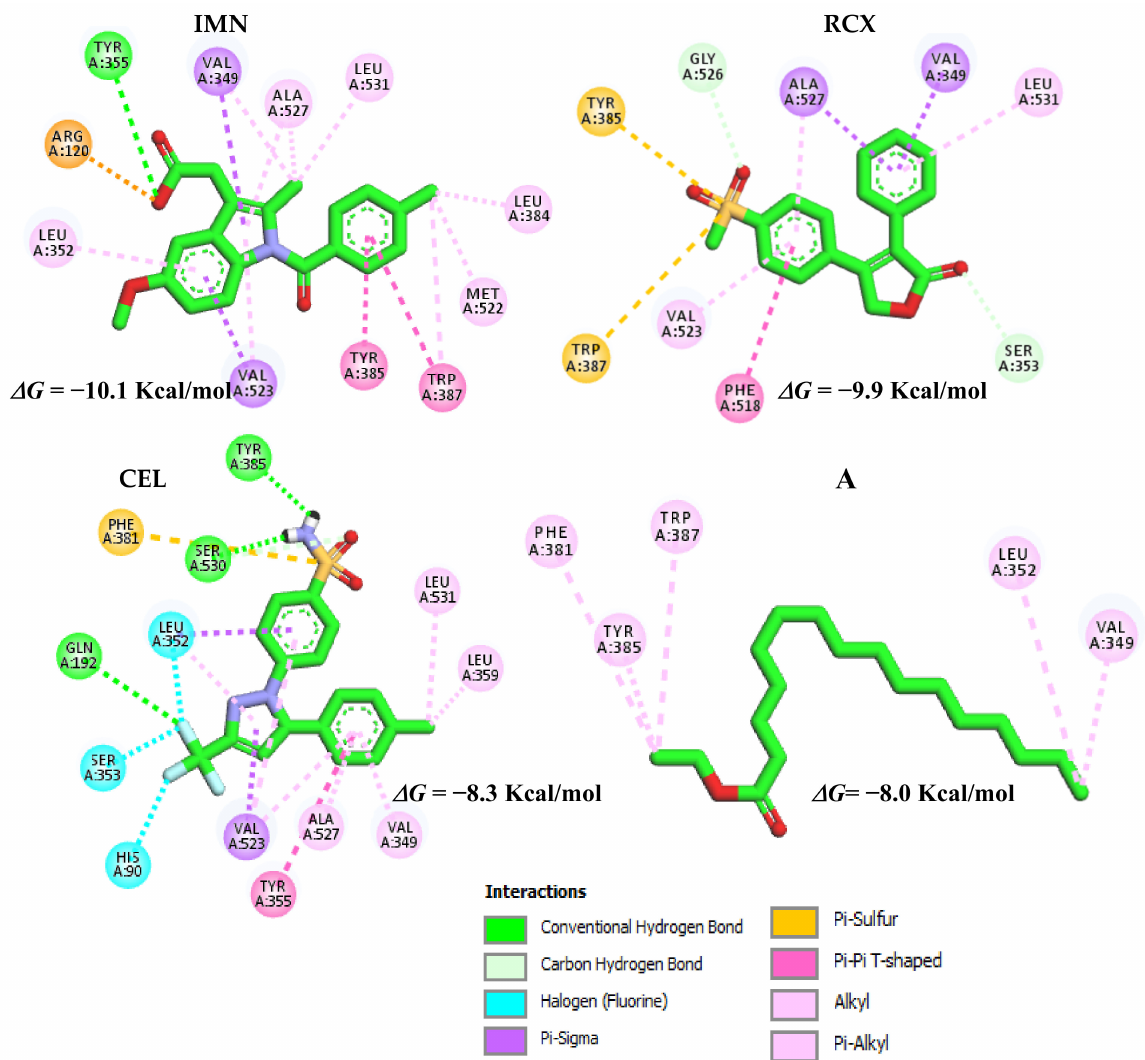
Figure 12. Interactions of IMN controls, RCX, CEL and potential inhibitor A with the COX-2 binding site (PDB ID: